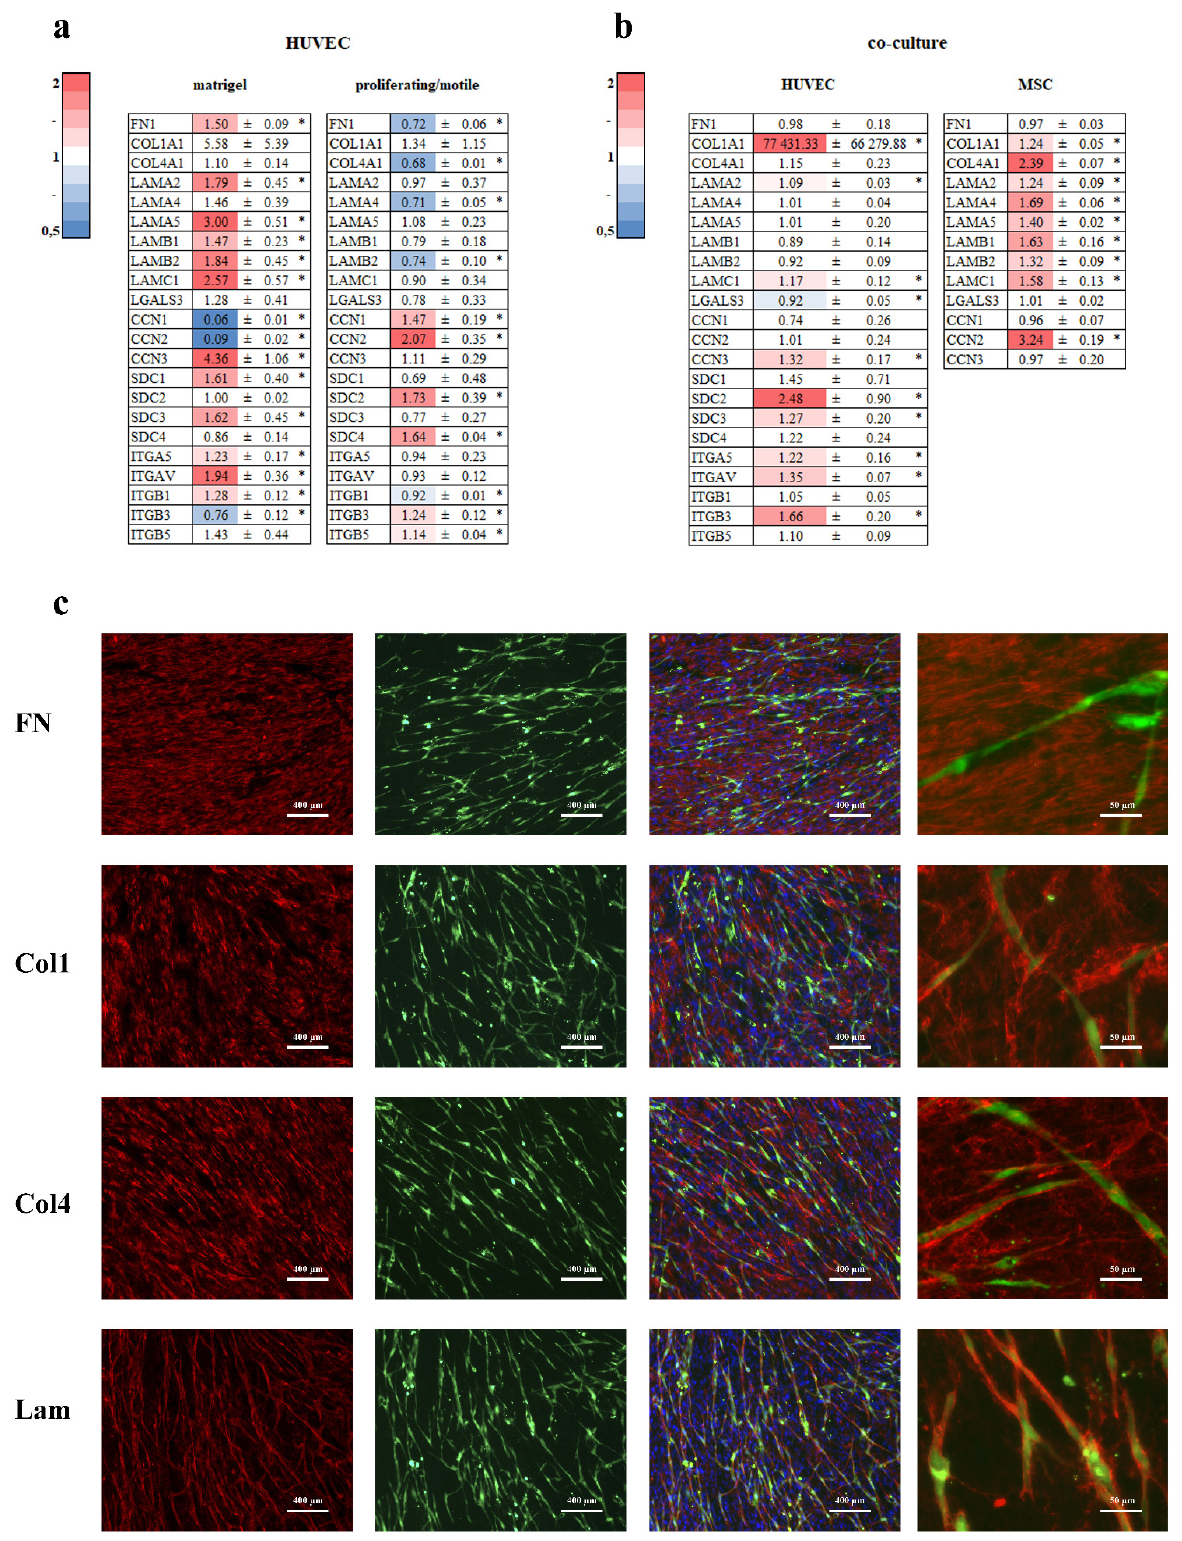
Figure 7. EM synthesis. HUVECs were grown on Matrigel TM ( a ), as proliferating/motile HUVECs, in co-culture with MSCs ( b ), or as a confluent monolayer for 19 h. Cells in direct co-culture were separated using anti CD31 magnetic beads. Total RNA was isolated and specific mRNA levels were quantified by qRT PCR as described in “Methods”. The data are presented as fold changes in the mRNA levels of HUVECs on Matrigel TM , in co-culture with MSCs, proliferating/motile